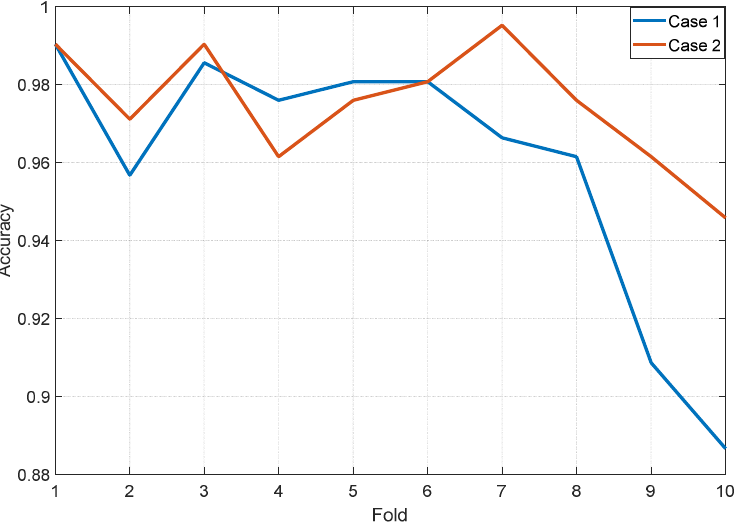
Figure 7. Accuracy (%) versus each fold of ten-fold cross-validation for the Cases 1 and 2.